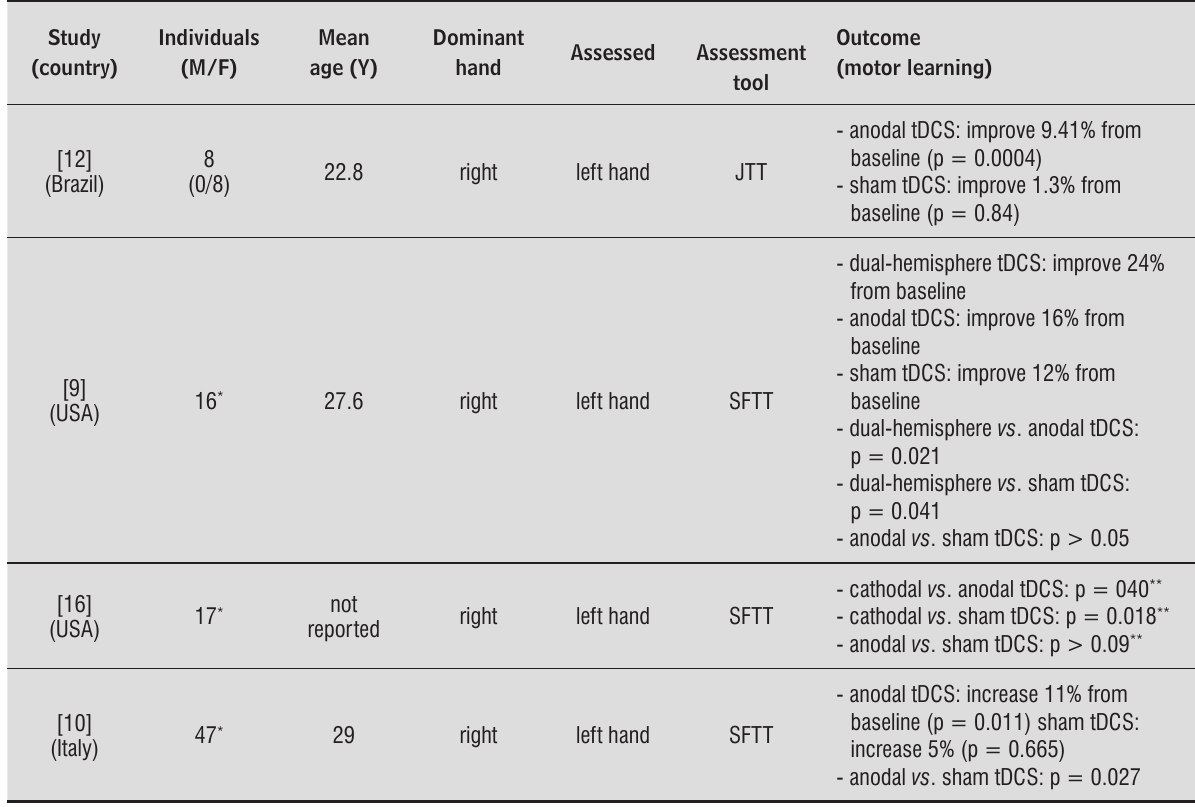
Table 3 - Characteristics of included